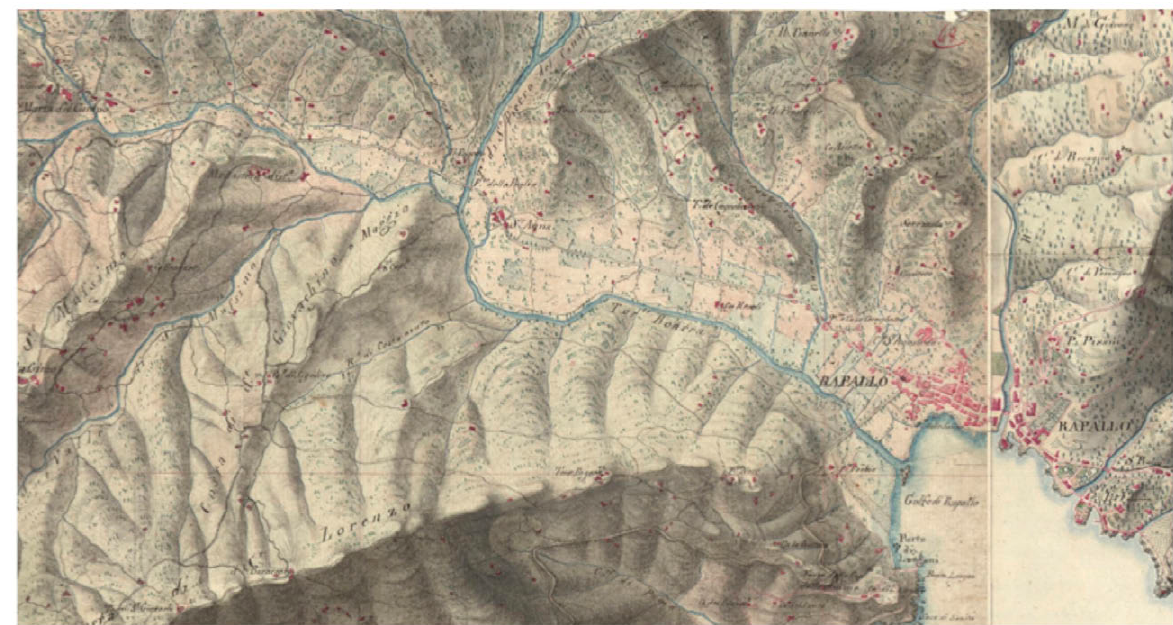
Fig. 6. Rapallo in the early nineteenth century (after Stati Sardi di Terraferma map, 1815–1823, from IGMI